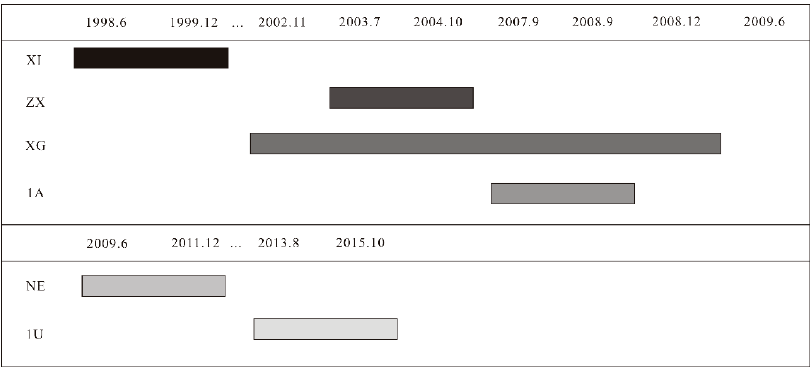
Figure 3. Time distribution of array recording.